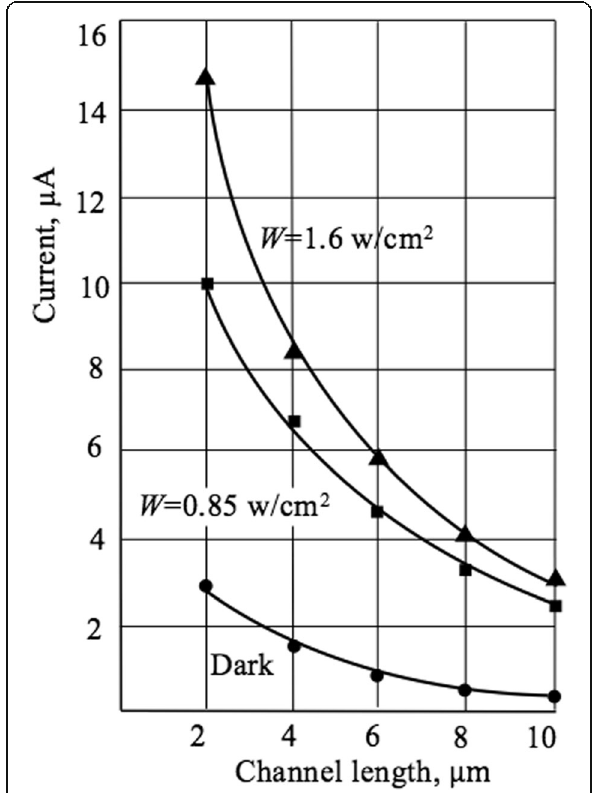
Fig. 9 Channel current of NW FET vs length. Plot of channel current as a function of channel length. V BG = − 5 V, V ds = − 5 V, R ch =1.26 M